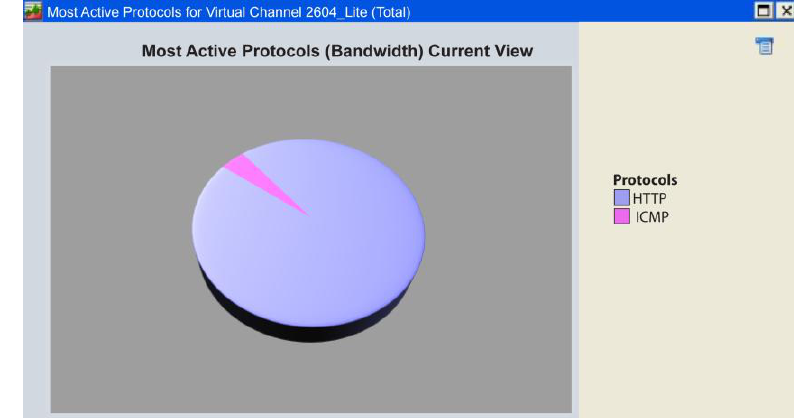
Figure 14. Most active protocols during data transmission when using satellite link